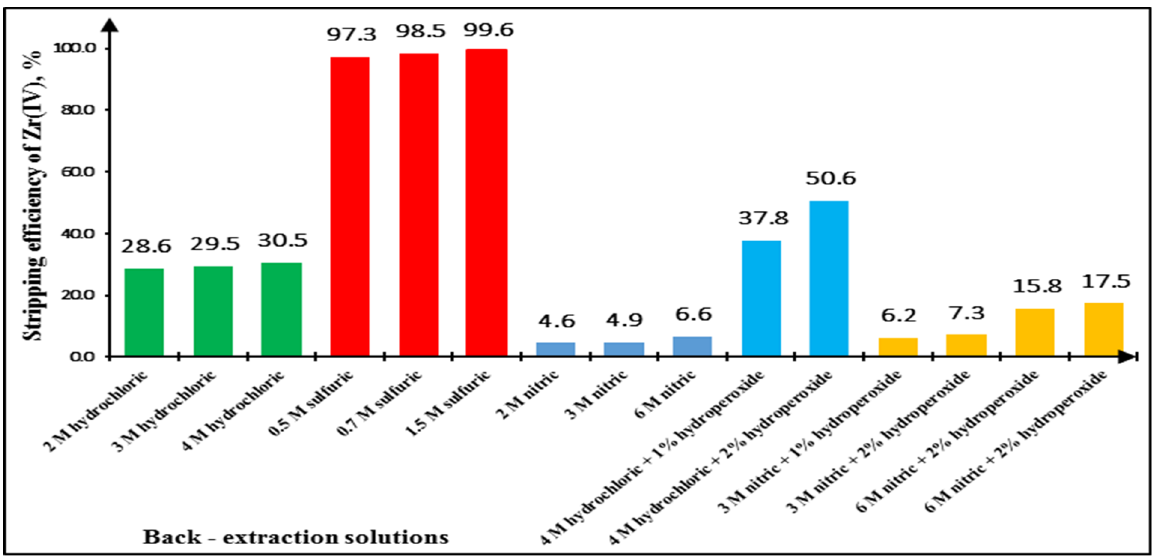
Figure 3. Back ‐ extraction efficiency (%) of Zr(IV) from loaded organic phase with 15 agents. Figure 3. Back-extraction efficiency (%) of Zr(IV) from loaded organic phase with 15 agents.